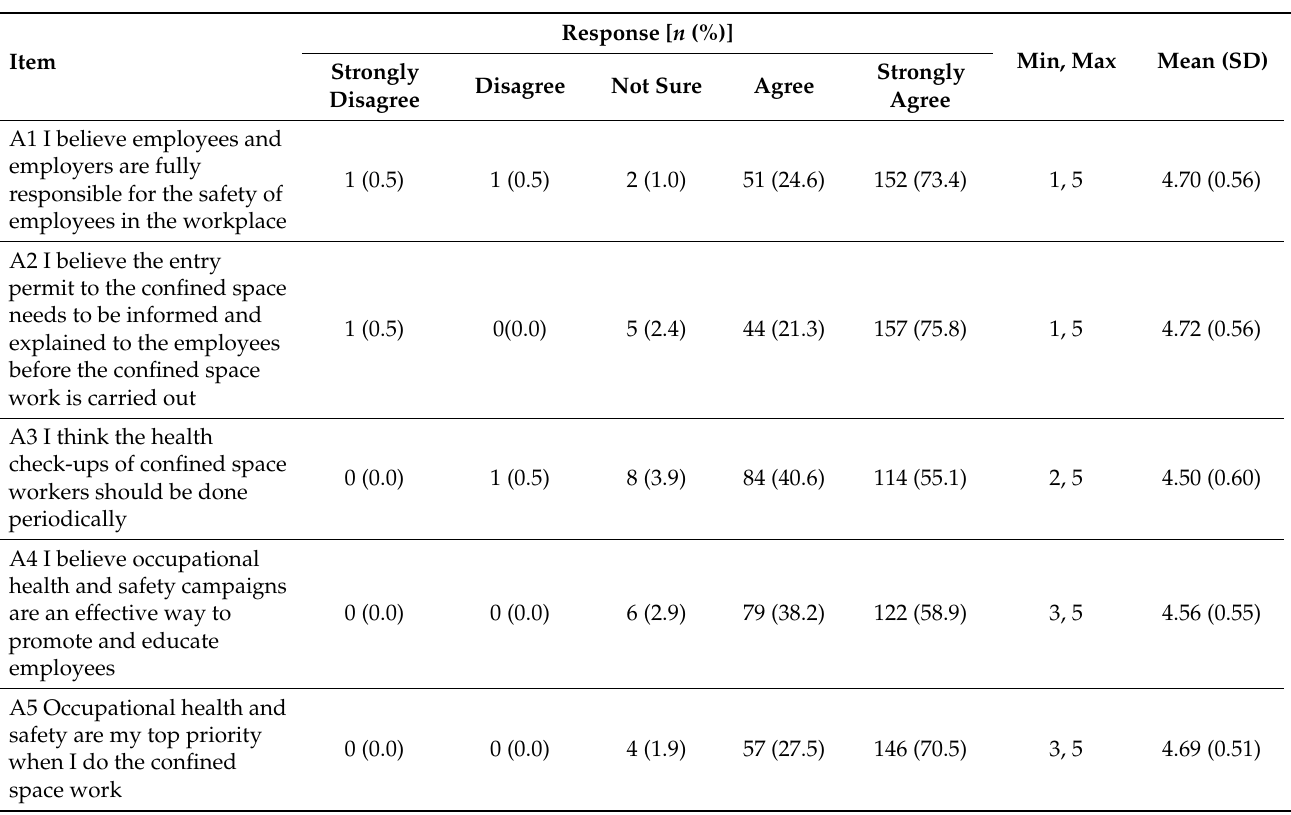
Table 2. Descriptive statistics of attitude on safe working in a confined space among water services workers ( n =